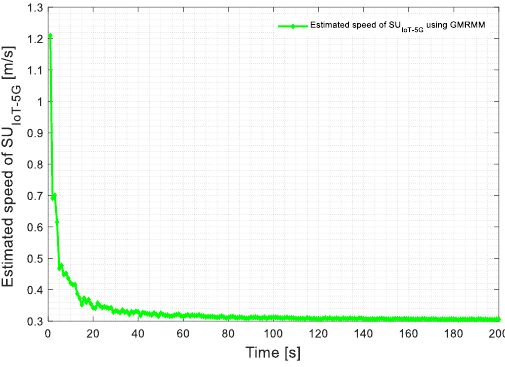
Figure 3 . Estimated speed of SU IoT-5G vs. Time [s].